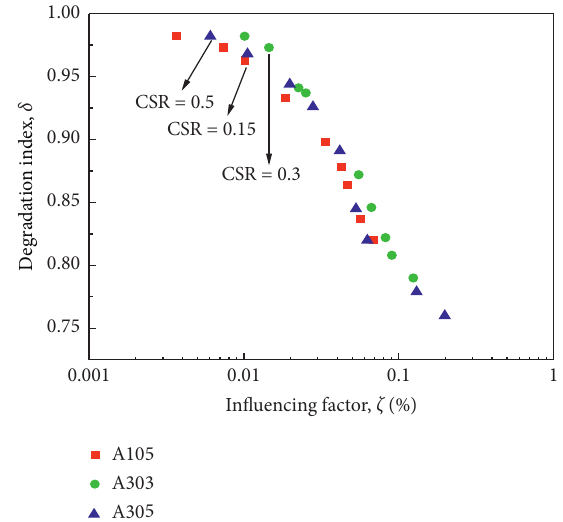
Figure 14: Relationship of the degradation index δ − ζ for different cyclic stress ratios